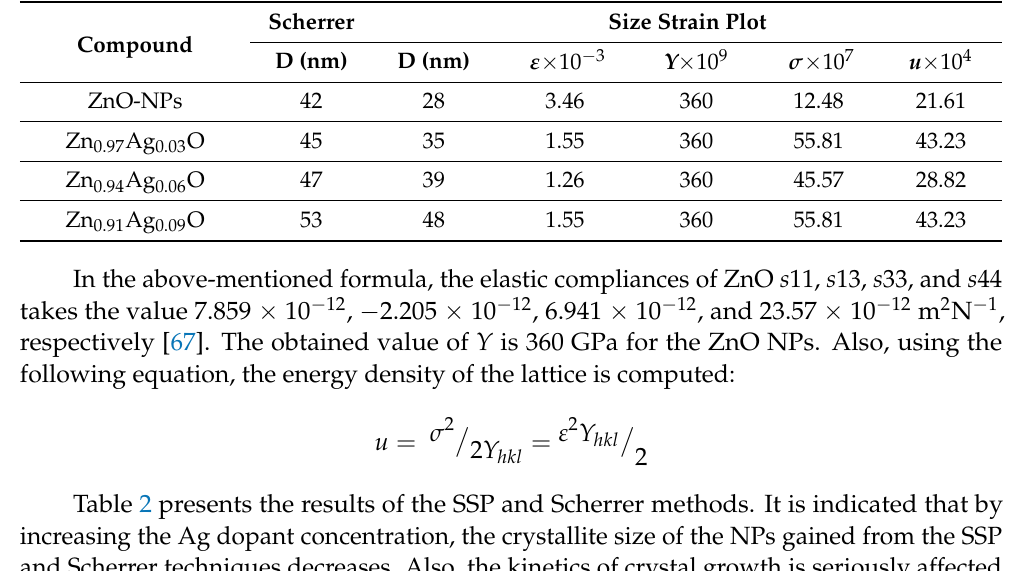
Table 2. Ag concentration-dependent elastic constants and the NPs’ sizes.